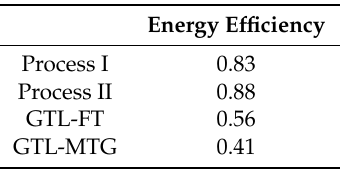
Table 4. Energy efficiency for the proposed processes and existing technologies. FT: Fischer–Tropsch; GTL: gas-to-liquid; MTG: